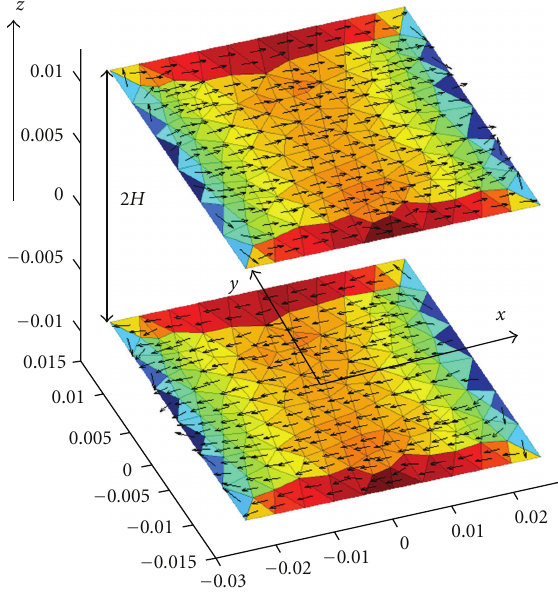
Figure 3: Model of MPA above infinite ground plane for H = 10mm, dominant mode TM 01 shown.